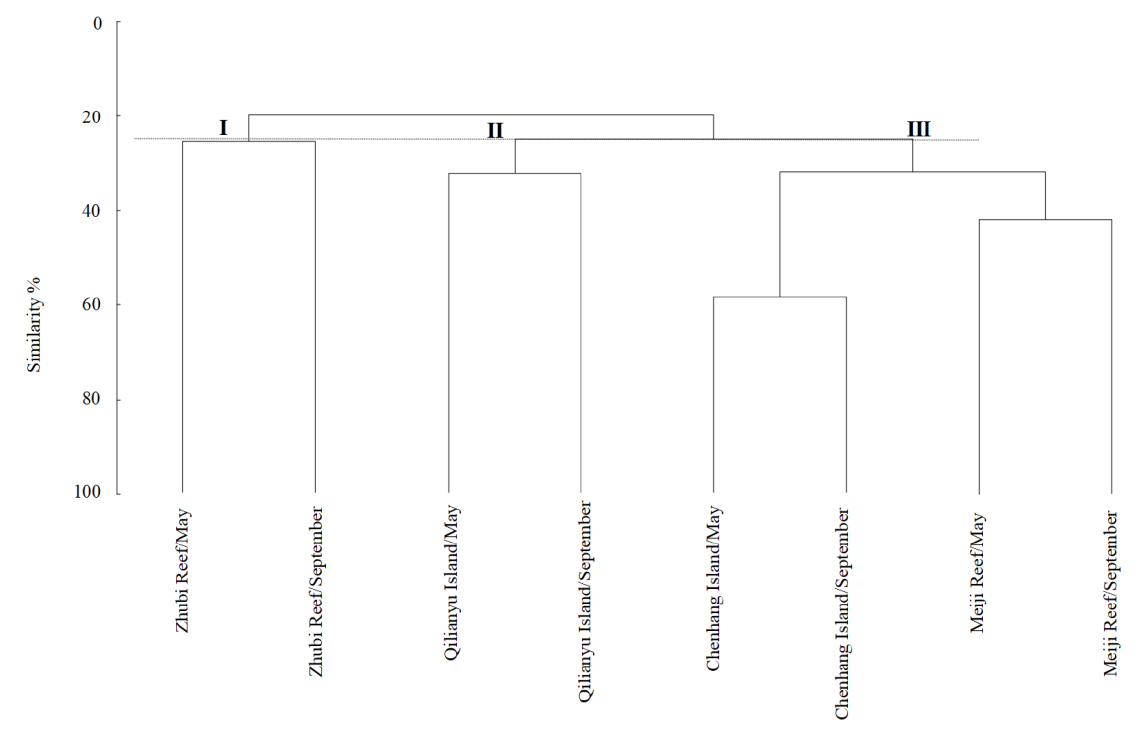
Figure 3. Group average clustering among fish communities at Meiji Reef, Zhubi Reef, Qilianyu Island and Chenhang Island in May and September.